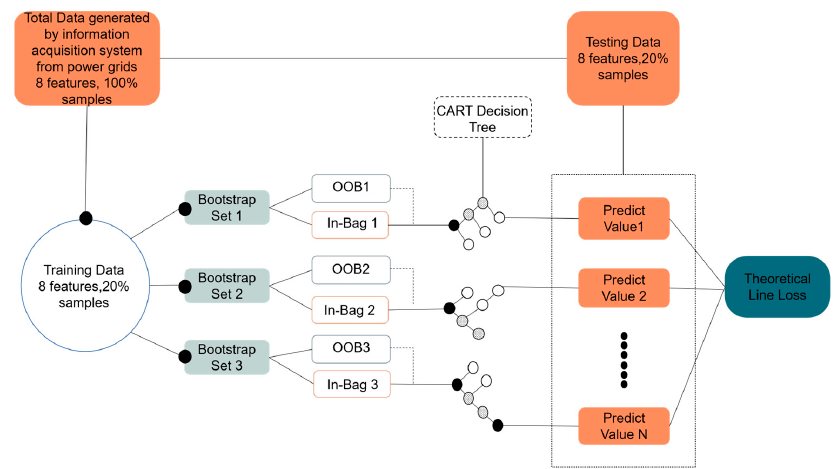
Figure 5. The schematic diagram of the topological structure of the RF algorithm.